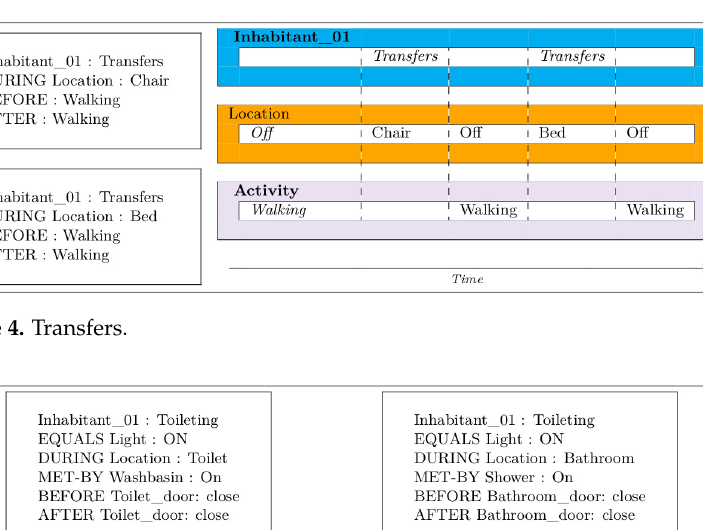
Figure 3. Dressing.